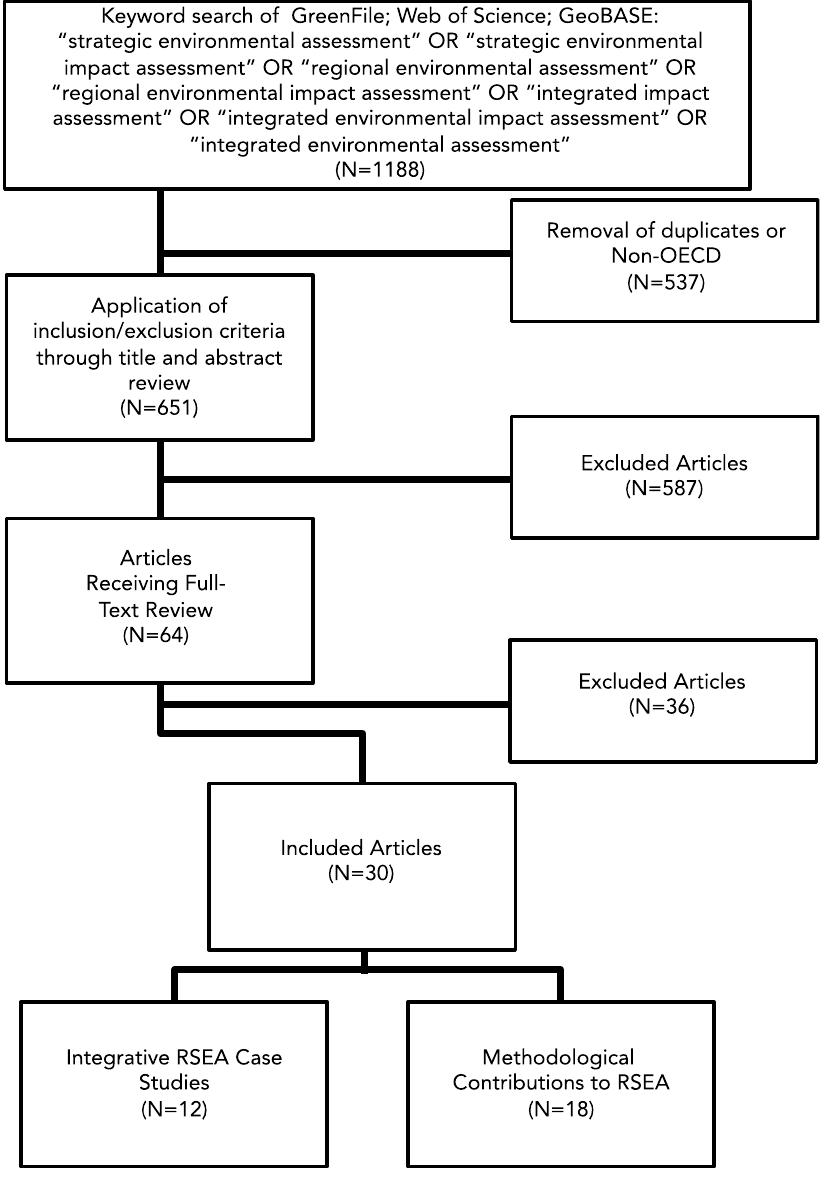
Figure 1. Search Strategy to Identify Examples of Integrated Regional and Strategic Environmental Assessment